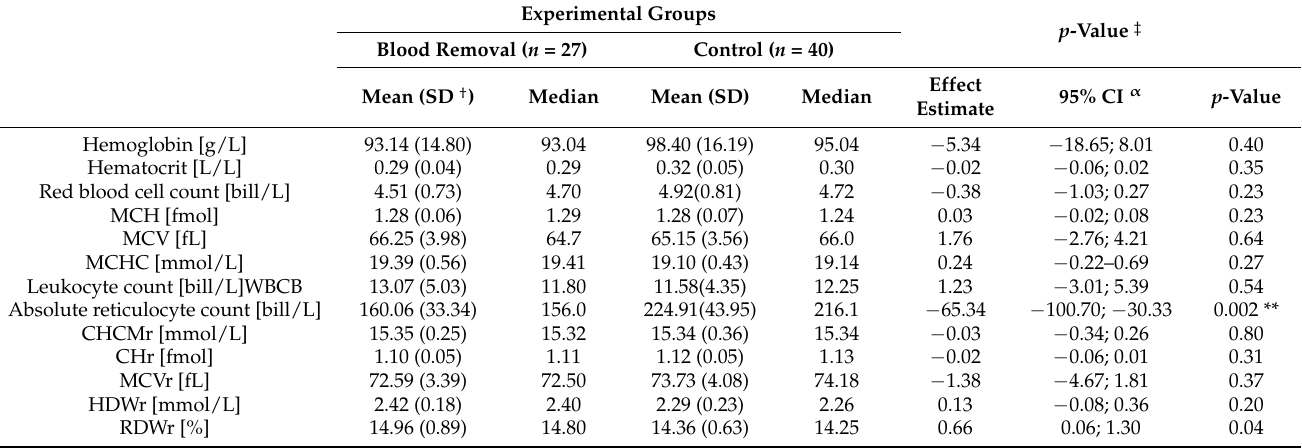
Table 6. Hematologic parameters of newborn piglets (Trial